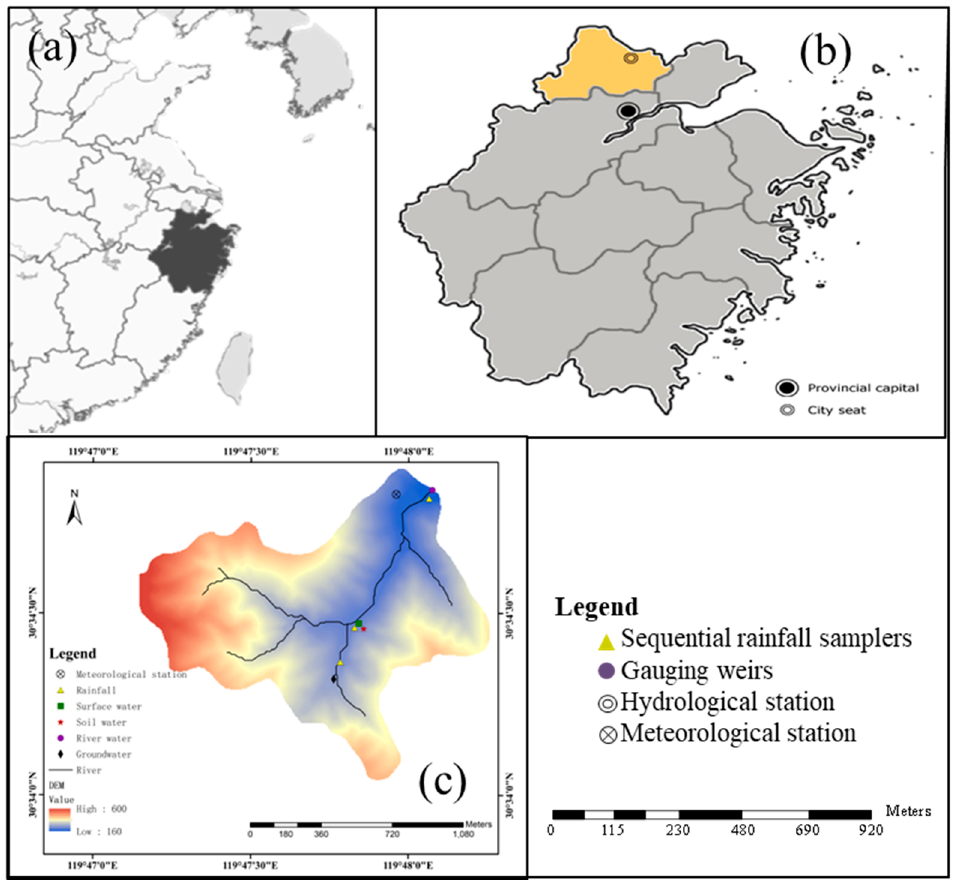
Figure 1. Locations of Hemuqiao catchment and distribution of sampling sites. ( a ) The location of Zhejiang Province in China. ( b ) The location of Huzhou City in Zhejiang Province. ( c ) Locations of sequential rainfall samplers, hydrological station and meteorological station in Hemuqiao catchment.